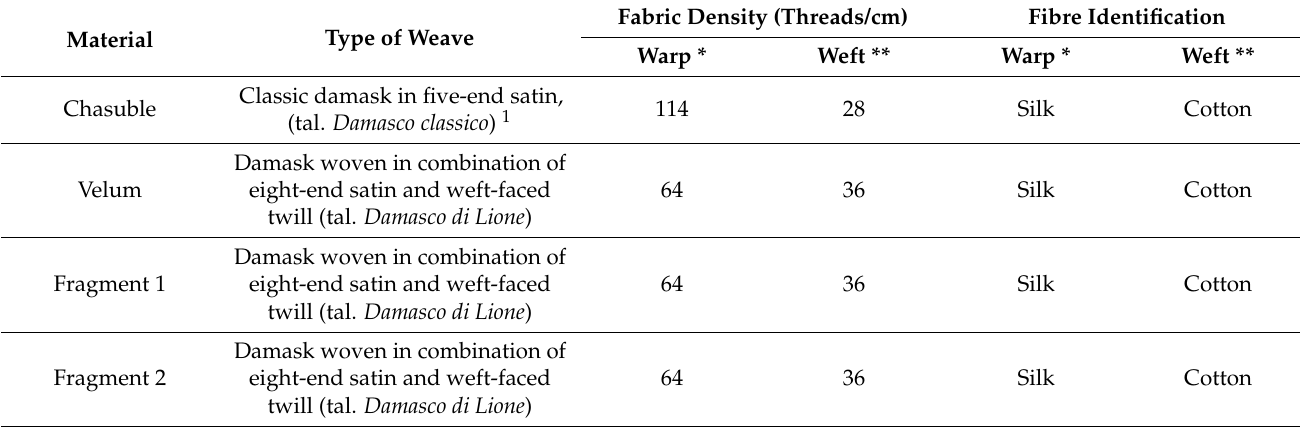
Table 2. Fabrics construction parameters and fibre